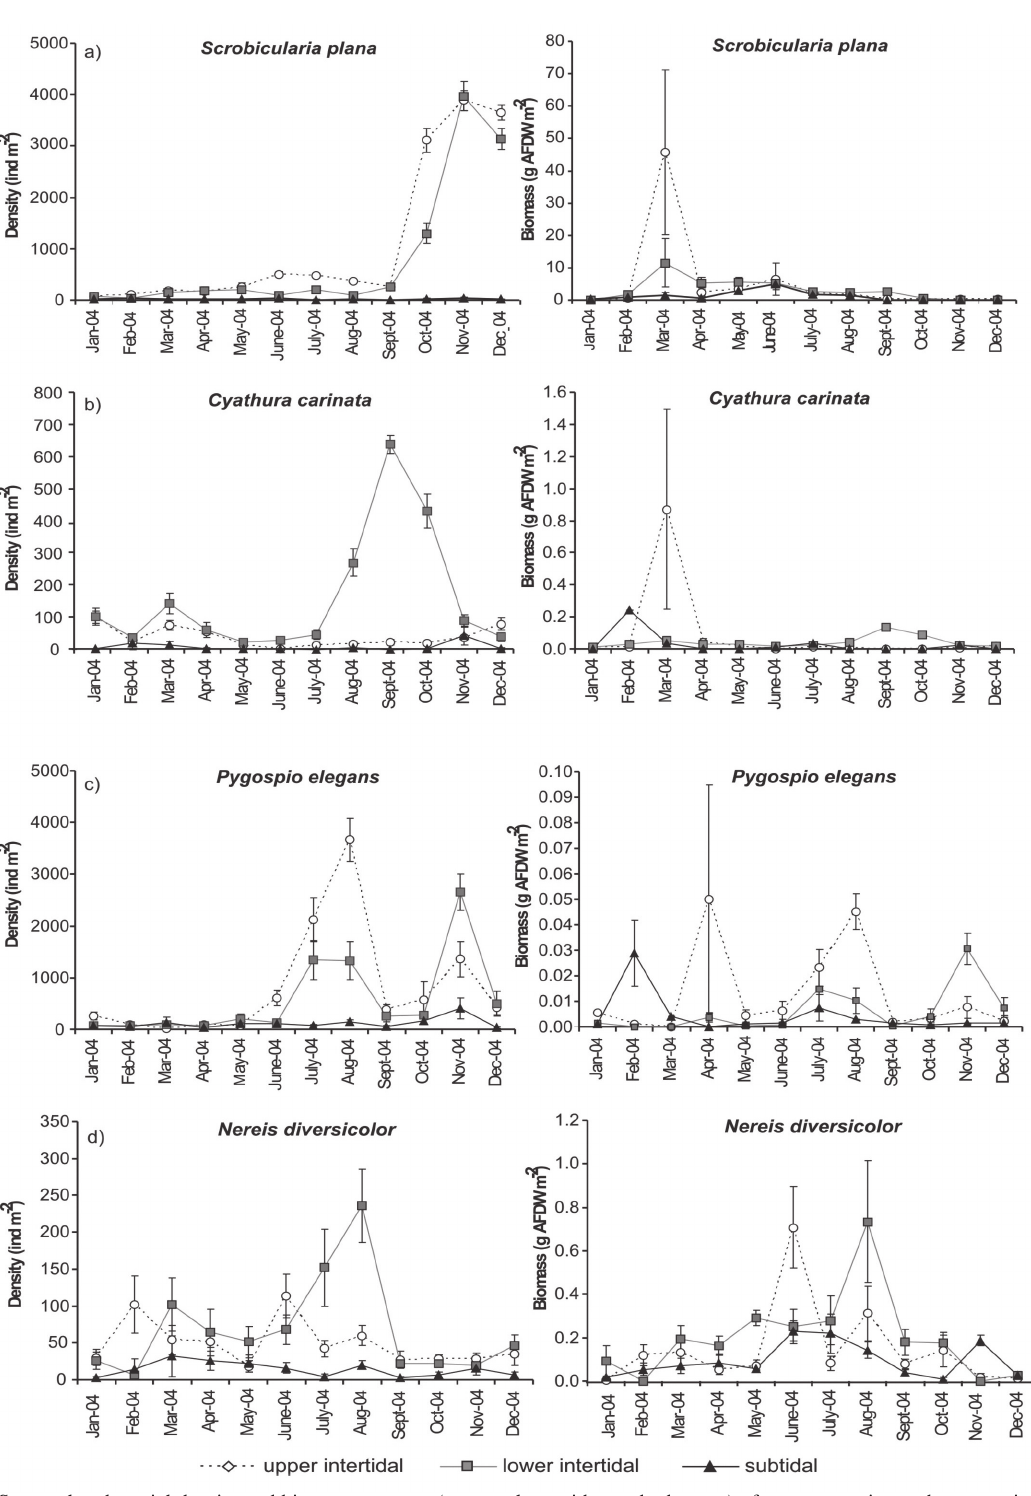
Fig . 3. – Seasonal and spatial density and biomass patterns (mean values with standard errors) of some macroinvertebrate species from the study area (a, Scrobicularia plana ; b, Cyathura carinata ; c, Pygospio elegans ; d, Nereis diversicolor